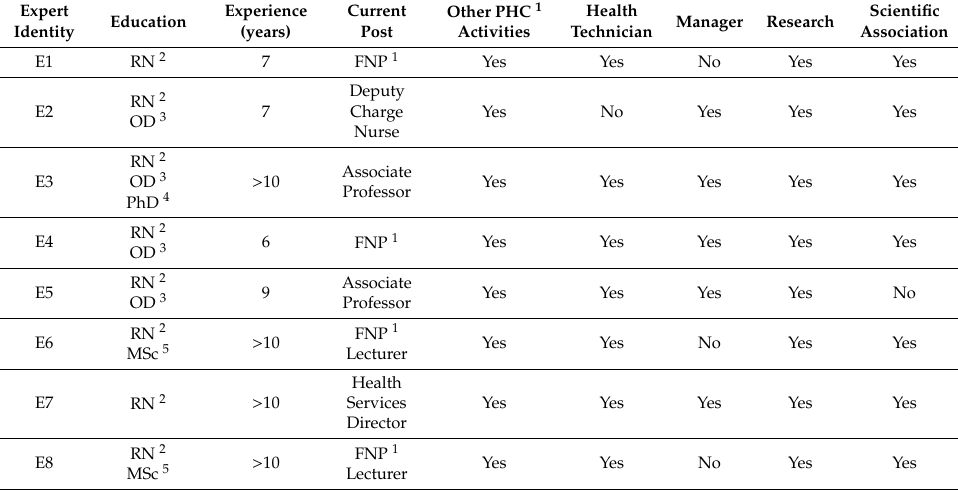
Table 1. Profile of experts participating in nominal